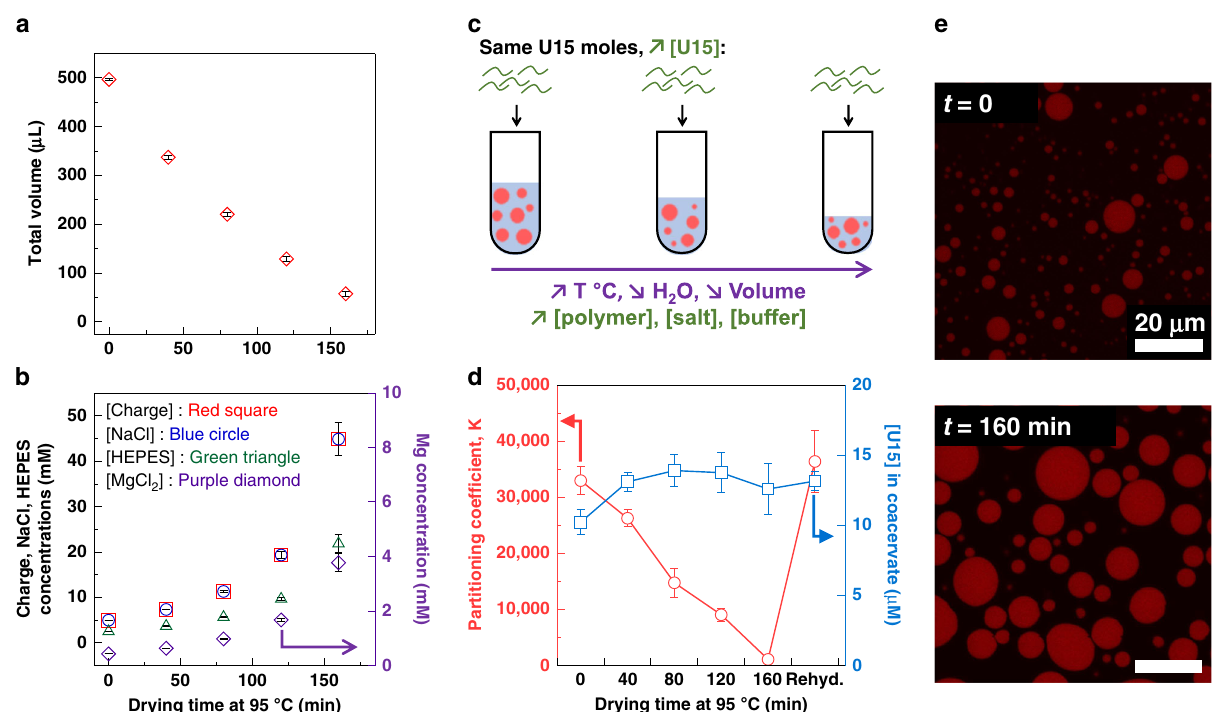
Fig. 2 Partitioning of U15, a 15-mer oligouridylic acid, during PDADMA/PAA coacervate suspension drying. a Total volumes of PDADMA/PAA complex coacervate at each time point of drying. Averages and standard deviations are obtained from 9 independent trials ( N = 27). The starting composition is the same for all samples: [polymer charge] = [NaCl] = 5 mM, [HEPES] = 2.5 mM, [MgCl 2 ] = 0.43 mM. b Calculated increase in the concentrations of the solution components. Standard deviations are among the same trials used to calculate the volumes above. c To understand the partitioning of RNA within the coacervate while avoiding risk of hydrolysis during the temperature-induced drying, Alexa 647-tagged U15 was added after each drying step was complete and the solutions returned to room temperature. Fluorescent U15 was added such that its global concentration increased in the same way as all the other components in solution had, during the drying steps. Overall concentrations of U15 were as low as 0.02 µ M and never increased above 0.2 µ M, which is around 25,000x less than the lowest polymer concentrations, and is not believed to interfere with phase separation. d The partitioning coef fi cient, calculated as [U15] coacervate phase /[U15] dilute phase , and U15 concentrations within the coacervate after addition of the fl uorescent RNA in equal numbers of moles. Means and standard deviations are obtained from three trials with analysis of 15 droplets over fi ve images, per trial. e Confocal fl uorescence microscopy images showing the partitioned U15 within the droplets. While the partitioning coef fi cients decrease, the internal concentrations do not change signi fi cantly as quanti fi cation in d and Supplementary Fig. 14 show. Individual data points are shown in Supplementary Fig.